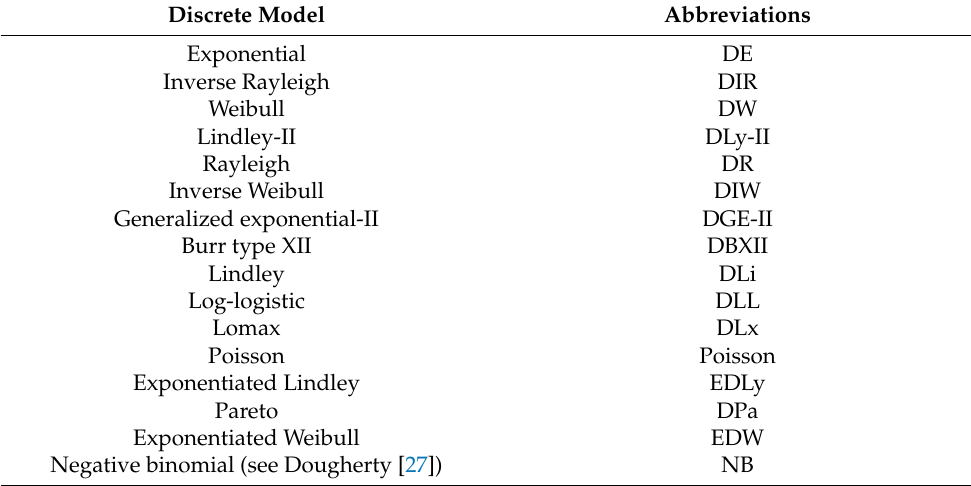
Table 12. The competitive models.